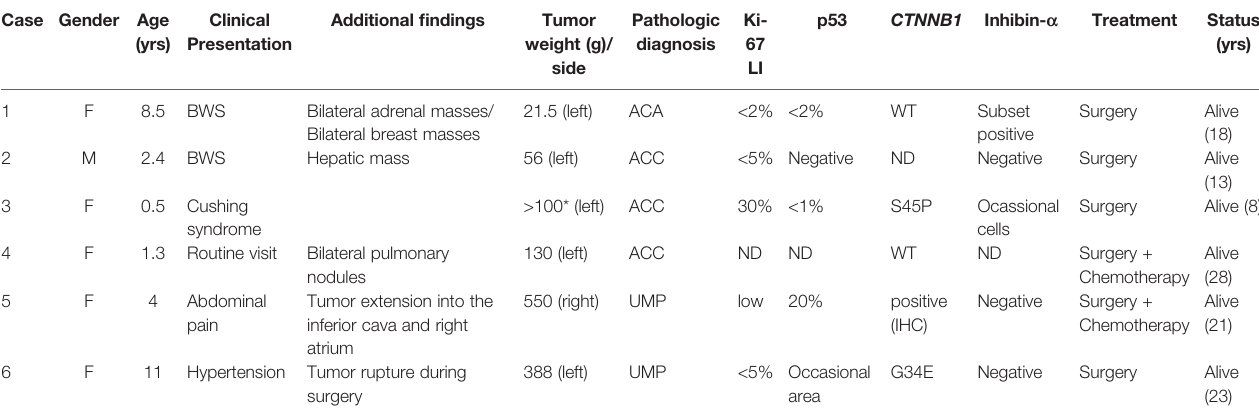
TABLE 1 | Clinical fi ndings of pediatric adrenocortical patients included in this study. Case Gender Age (yrs)